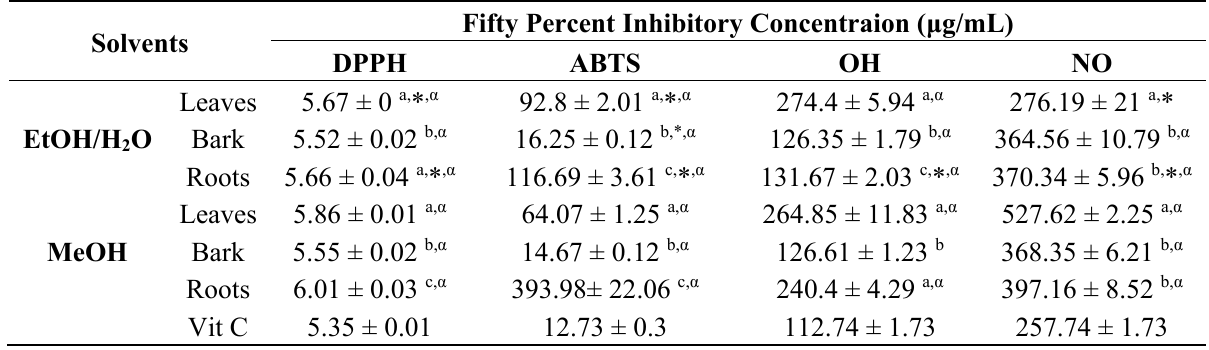
Table 6. Variation of fifty percent inhibitory concentration (IC 50 ) of different extracts of S. guineense